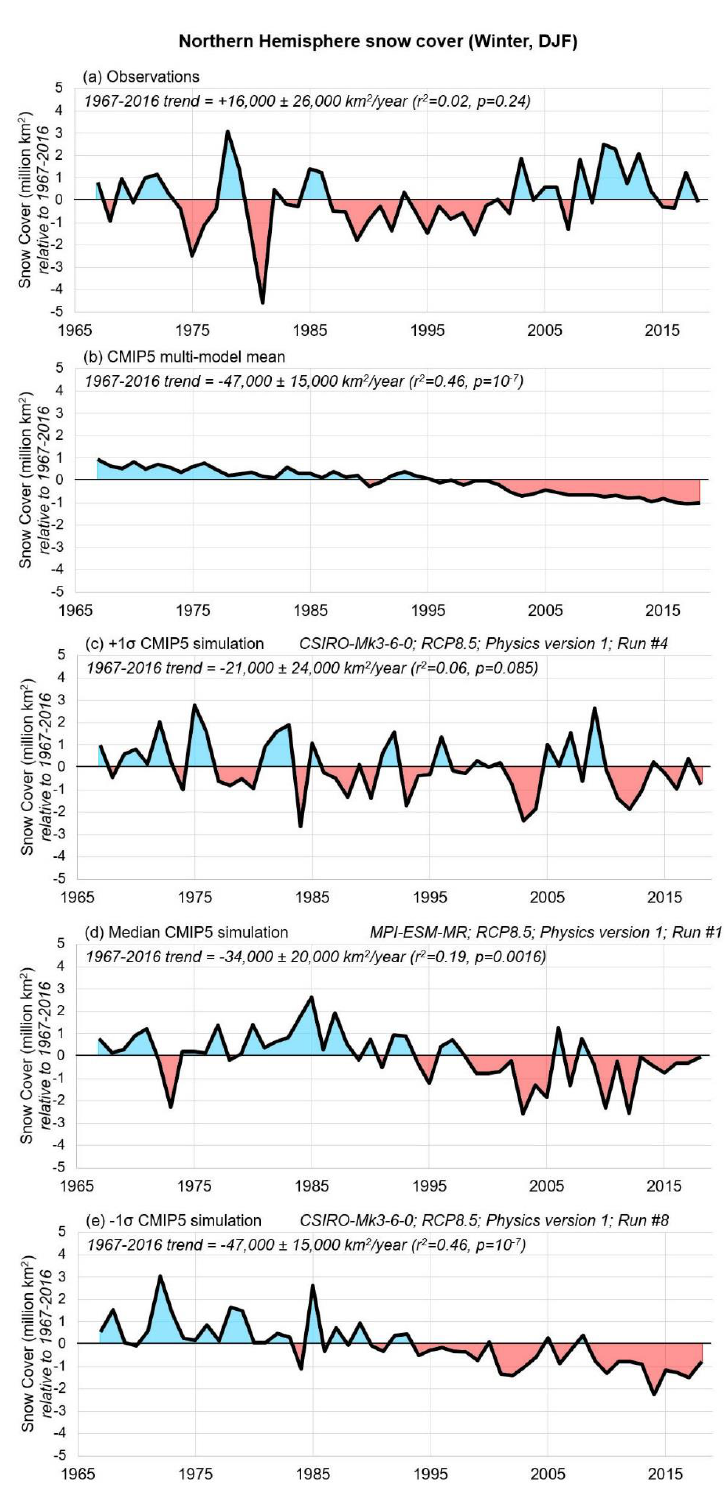
Figure 5. Same as Figure 4, except showing the winter (DJF, i.e., December, January and